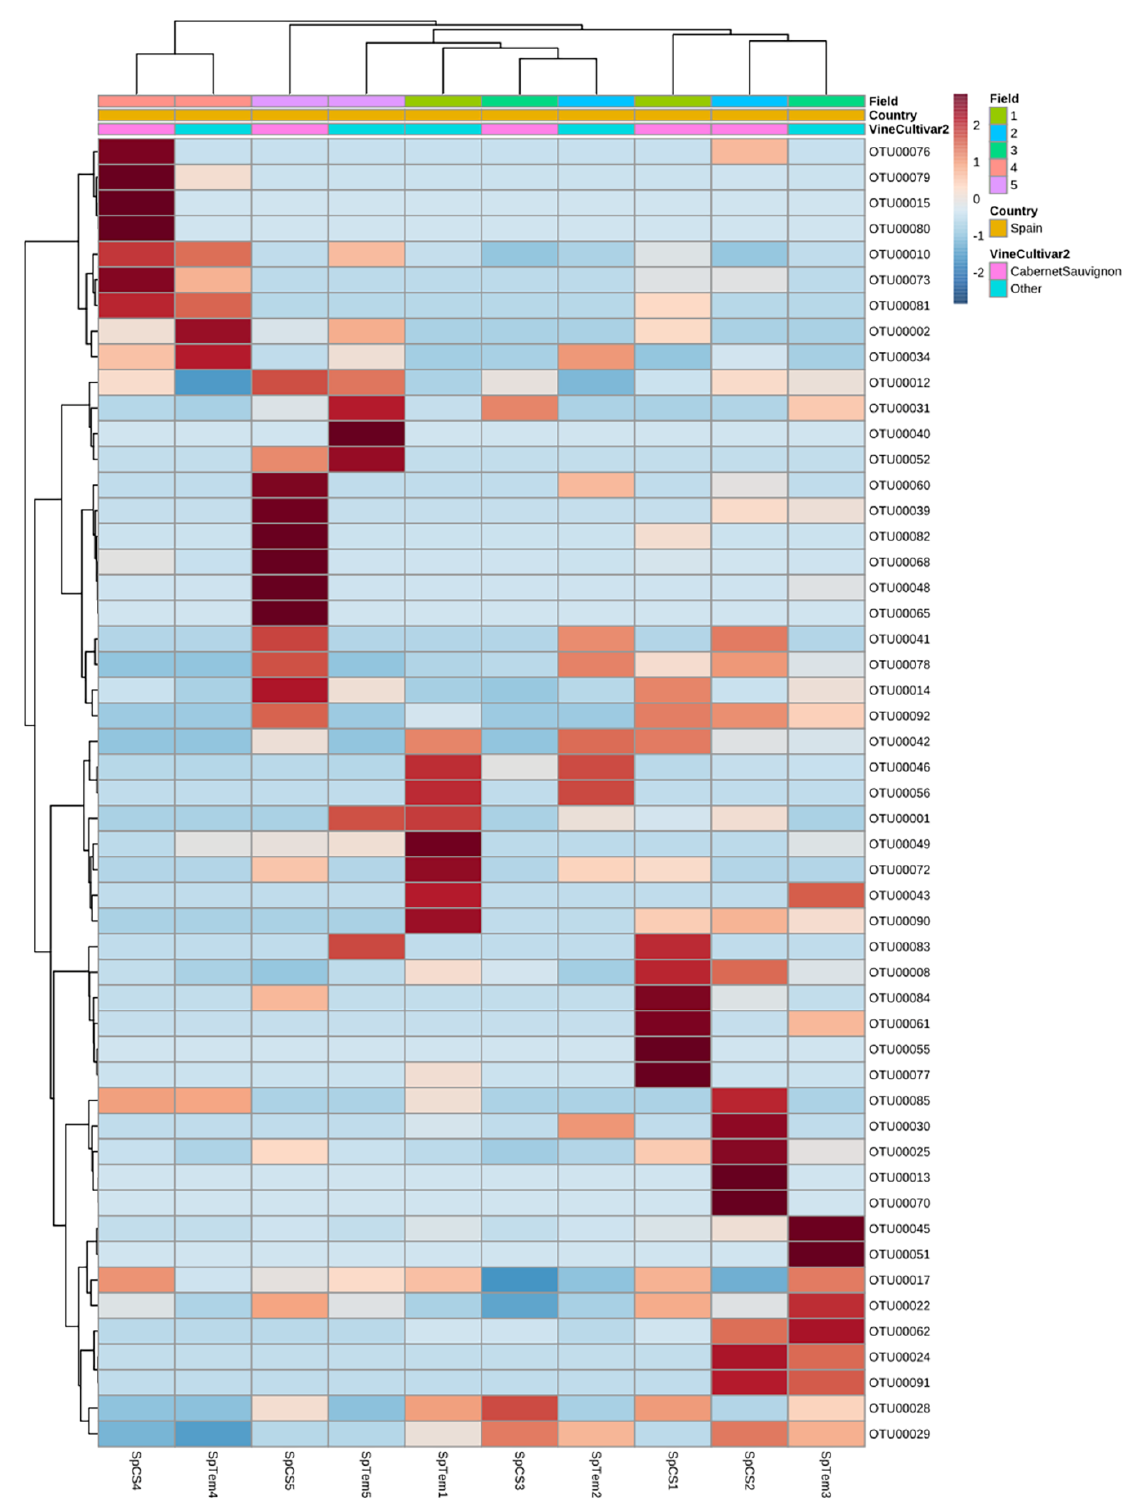
Figure A9. Clustered heatmap showing the variation of taxonomic abundance with regard to Spain (country) and cultivar samples [Cabernet Sauvignon and others (local cultivars)]. Sample code: Sp, Spain; CS, Cabernet Sauvignon; Tem, Tempranillo.